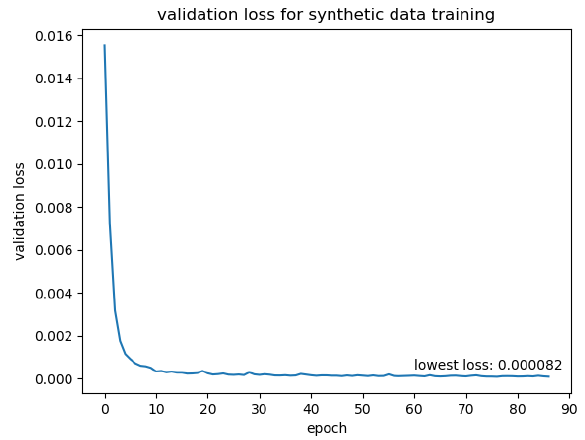
Figure 12. Validation loss over synthetic data training.